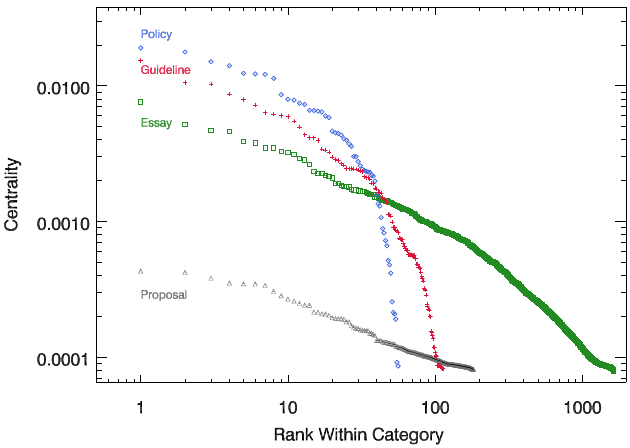
Figure D.1. Ranked eigenvector centrality for pages, broken out by page category. Policy (blue diamond) and guideline (red plus) pages dominate the system. More interpretive essays (green squares; includes humor and related pages), the most common by number, appear at lower relative rank; the highest ranked essay, for example, has lower centrality than the 10th ranked policy. Proposals, failed or current (grey triangles), are the lowest ranked of all.